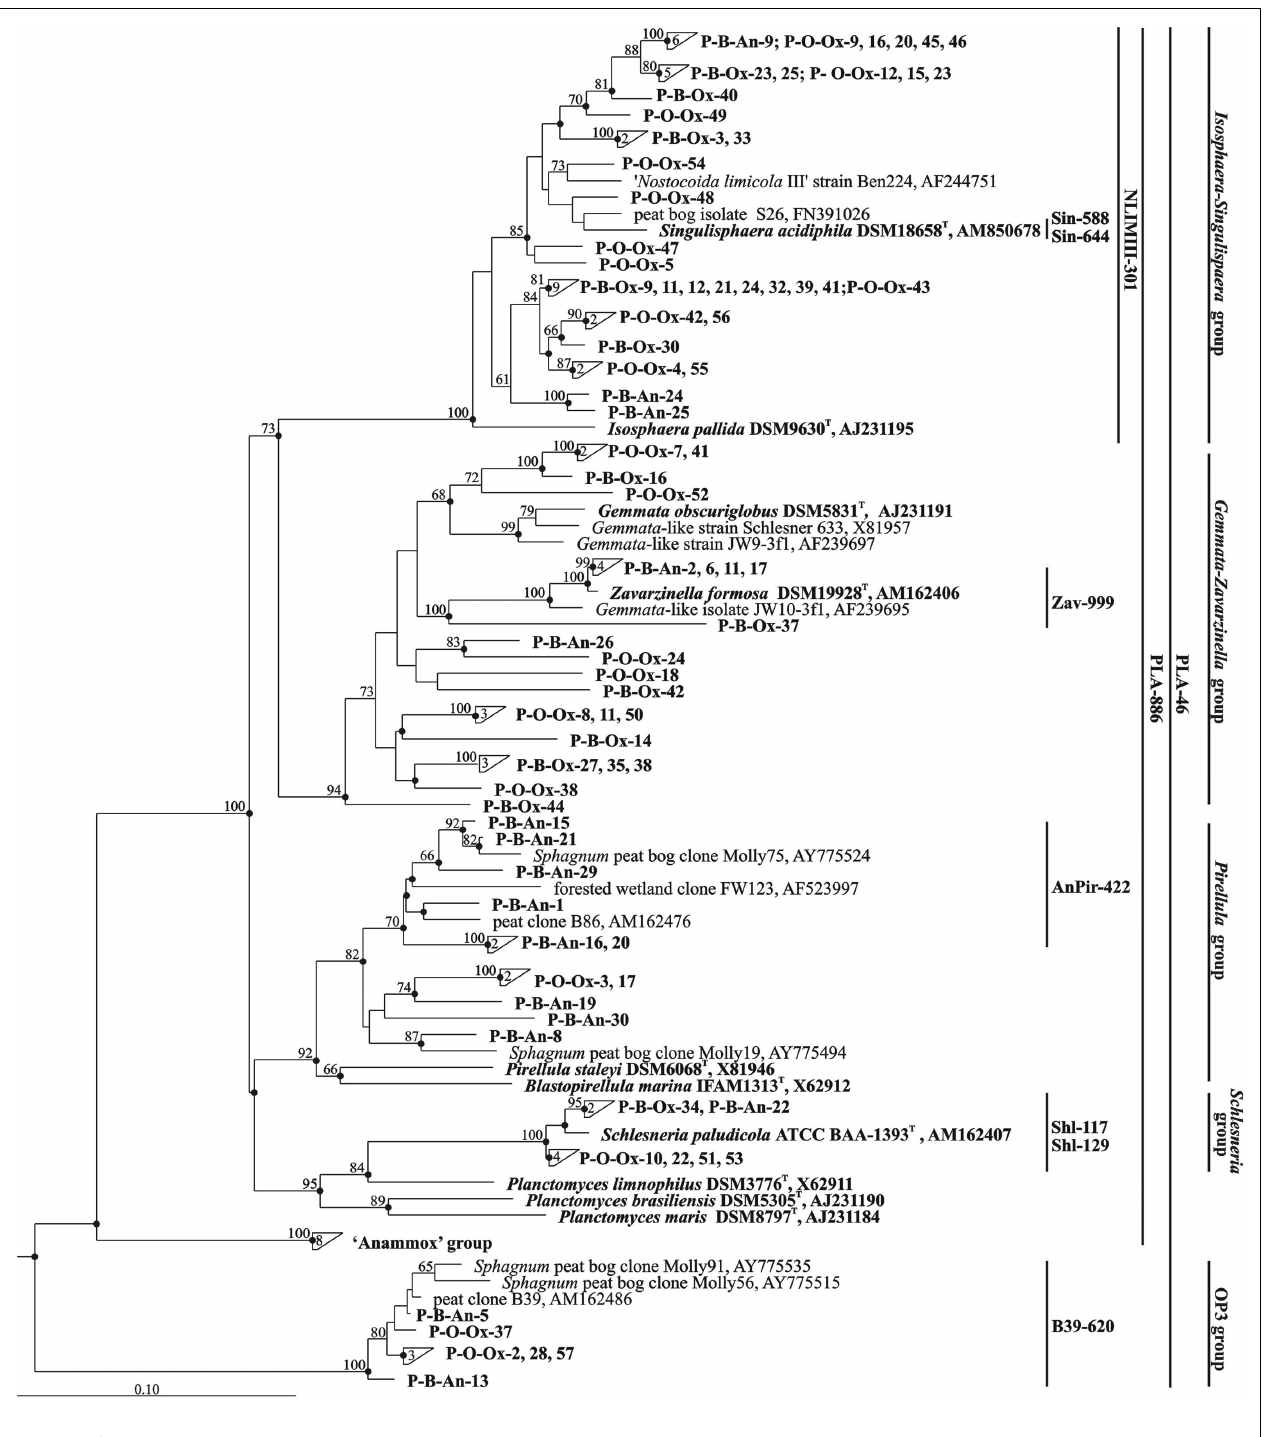
FIGURE 4 | Neighbor-joining phylogenetic tree showing the relative positions of 80 peat-derived clones and 16S rRNA gene sequences of taxonomically described planctomycetes. Environmental sequences that were retrieved from oxic and anoxic peat layers of the peat bog Bakchar are labeled as B-Ox and B-An, respectively.The clones obtained from oxic peat layer of the peat bog Obukhovskoye are indicated as O-Ox. The numbers inside triangles indicate the number of sequences in these